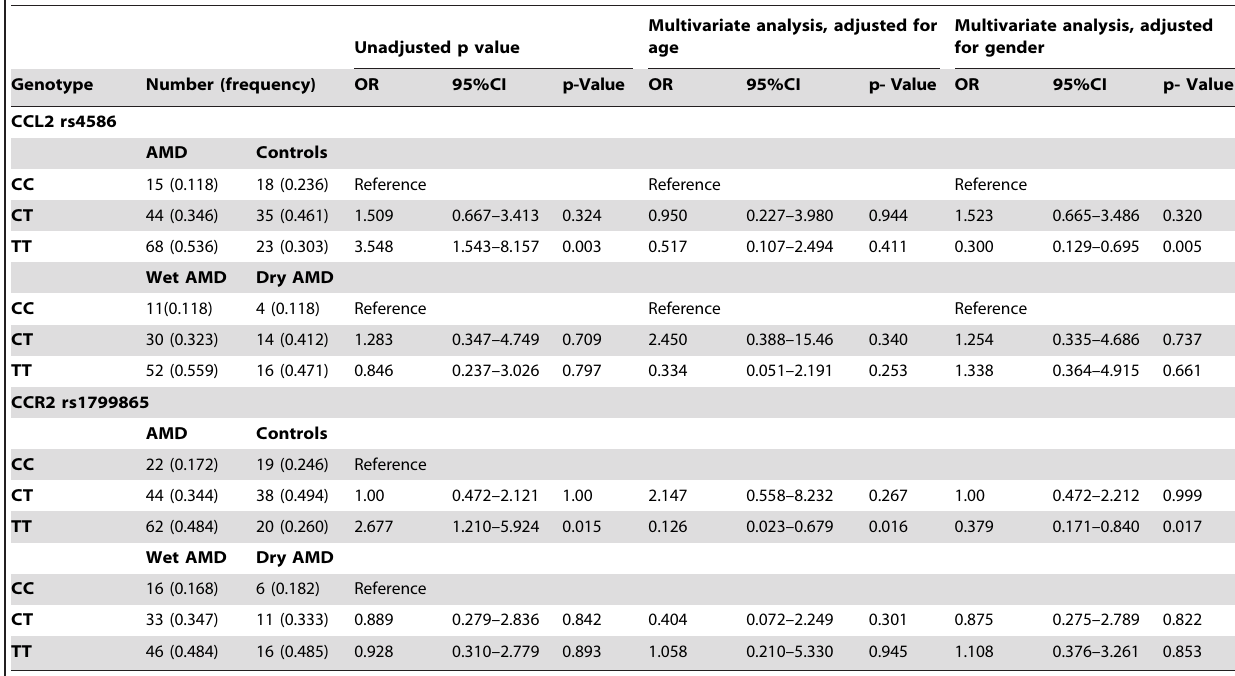
This table summarizes the genotype frequencies for the single-nucleotide polymorphisms (SNPs) in CCL2 rs4586 and CCR2 rs1799865 among patients with age-related macular degeneration (AMD) and control subjects. Genotype distributions were in Hardy-Weinberg equilibrium. The p-value represents comparison of risk significance between AMD cases and controls. OR indicates odds ratio and CI refers to confidence interval.